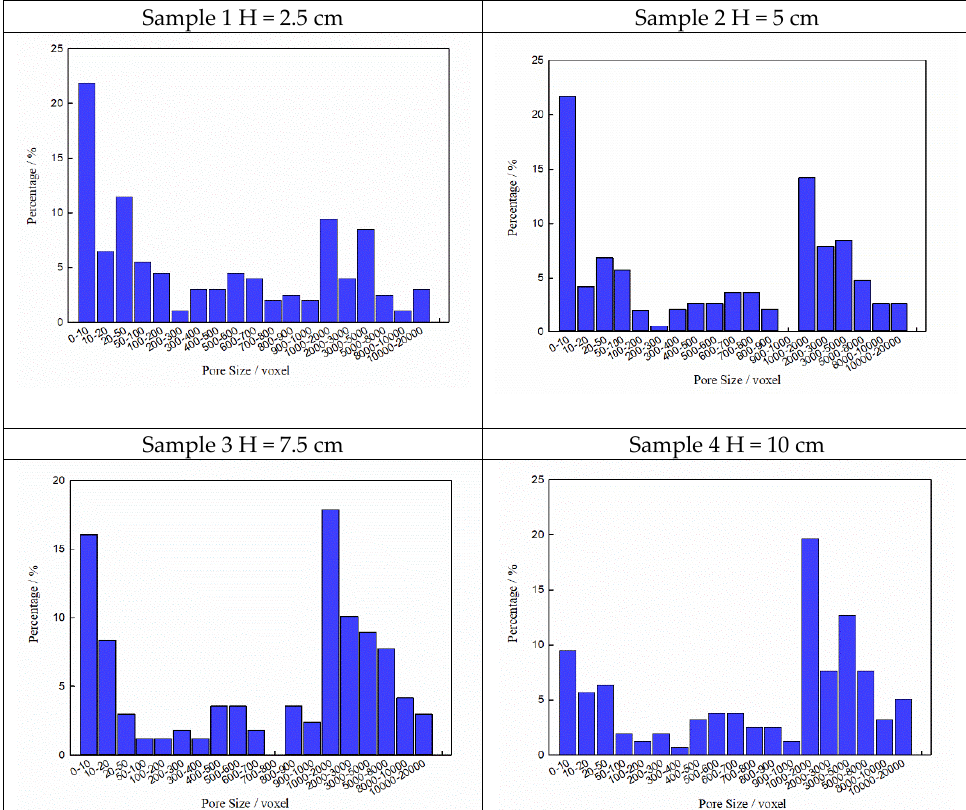
Figure 9. 3D pore volume distribution.